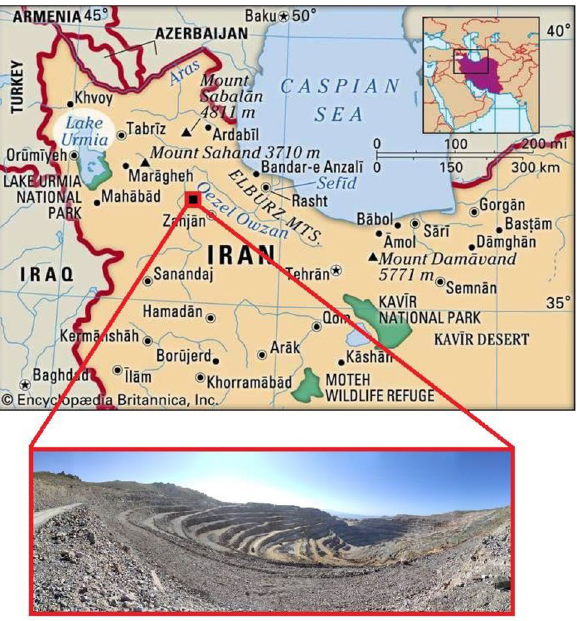
Figure 1. Location of Anguran lead–zinc mine and designed pit 73 (this figure is modified by EdrawMax, version 12.0.7, www. edraw soft. com).